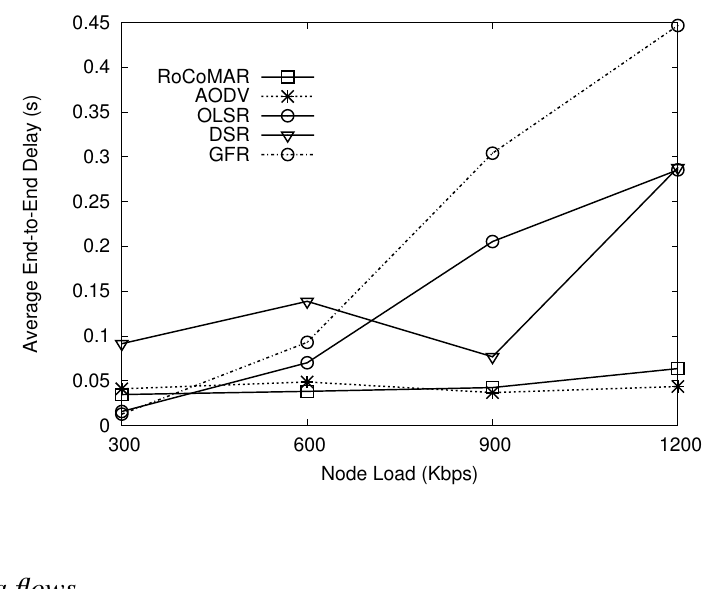
Figure 10. Effects of network traffic on average end-to-end